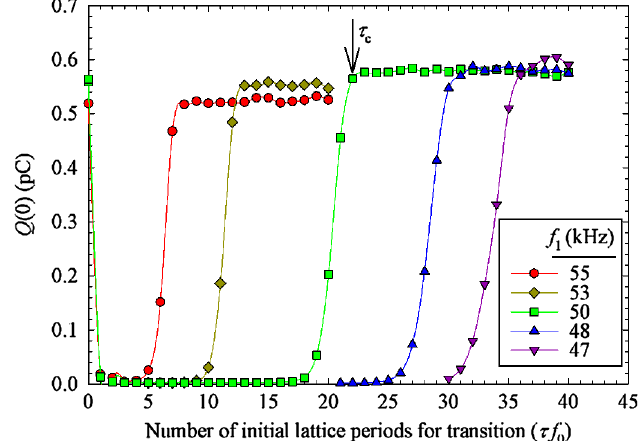
FIG. 9. (Color) The measured on-axis charge Q (cid:6) 0 (cid:7) , which is proportional to the peak plasma density, varies with the number of initial lattice periods over which the increase in ! Adiabatic decreases in the average frequency (cid:7) (cid:6) t (cid:7) = 2 (cid:1)t com- press the plasma and raise the on-axis charge Q (cid:6) 0 (cid:7) only if the transition time (cid:9) is greater than some critical time (cid:9) plasma confinement is lost. The exception is if the decrease in frequency is made